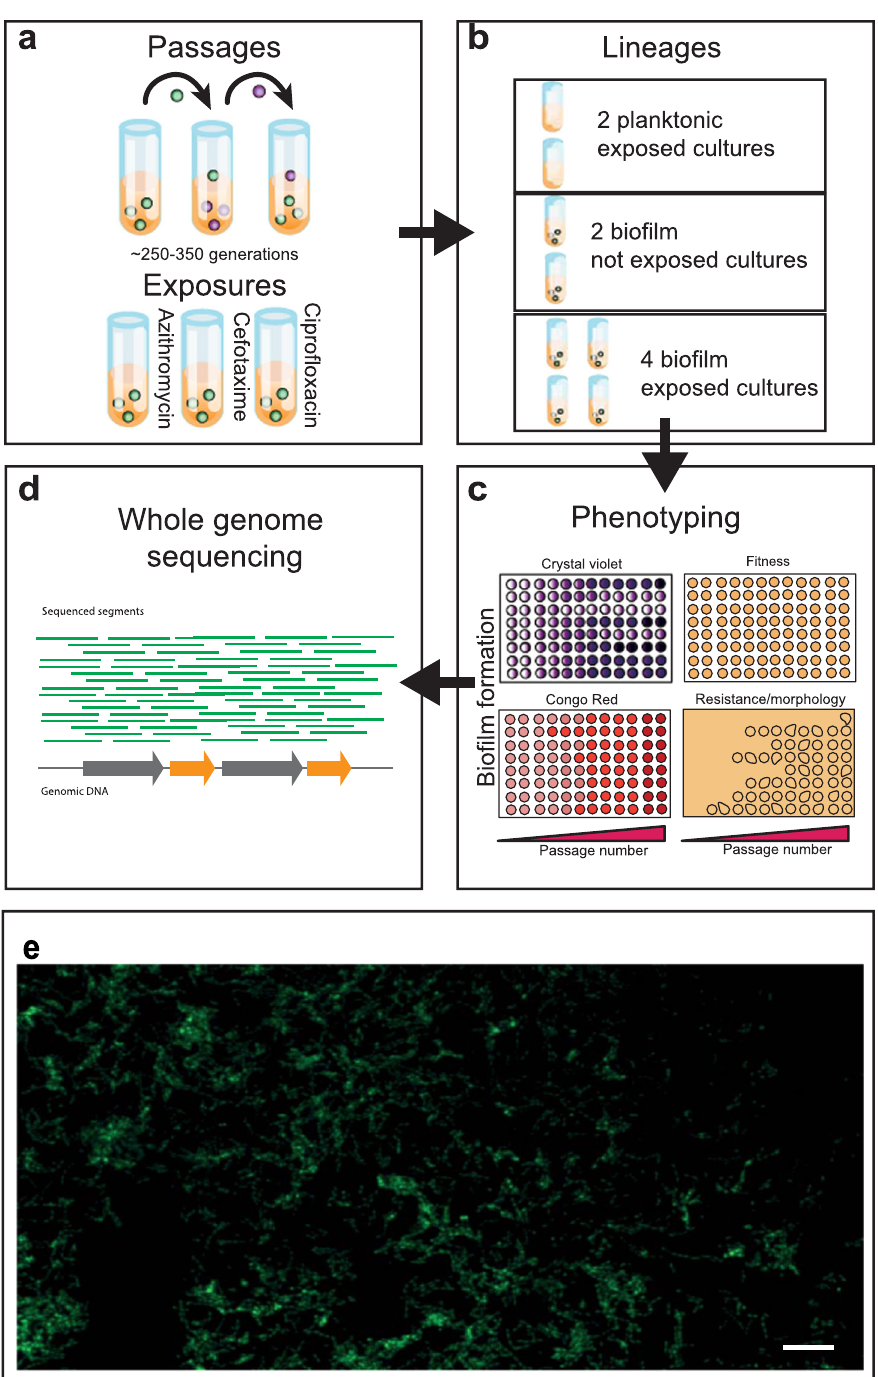
Fig. 1 Bio fi lm adaptation model. a Sterile beads were used for the establishment of bio fi lms. Bio fi lms formed on the beads were exposed to azithromycin, cefotaxime or cipro fl oxacin. b Eight independent lineages were included per experiment: two planktonic controls, two drug-free bead controls and four bio fi lm test lineages. c Cells were isolated every 72 h after incubation at 30 °C and phenotyped using several assays. d Whole-genome sequencing was used for the genetic characterisation of selected strains. e Confocal microscopy image (×40) of the parental strain, 14028S bio fi lm formed on a glass bead after 72 h. Cells were stained with SYTO9 before being visualised. Scale bar indicates 5